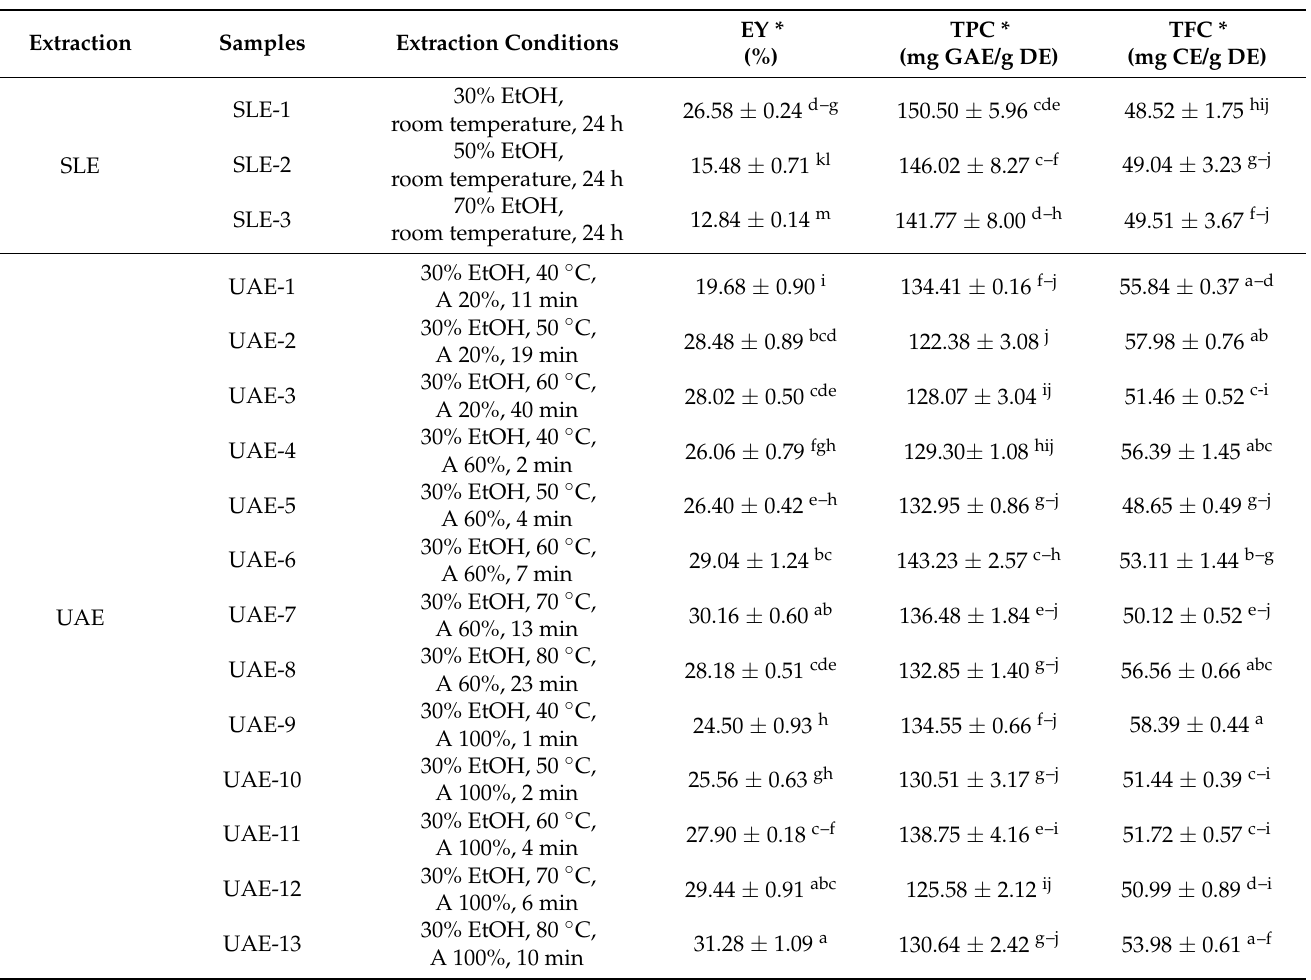
Table 1. EY, TPC and TFC values obtained for black elderberry press cake using different extraction techniques under different extraction